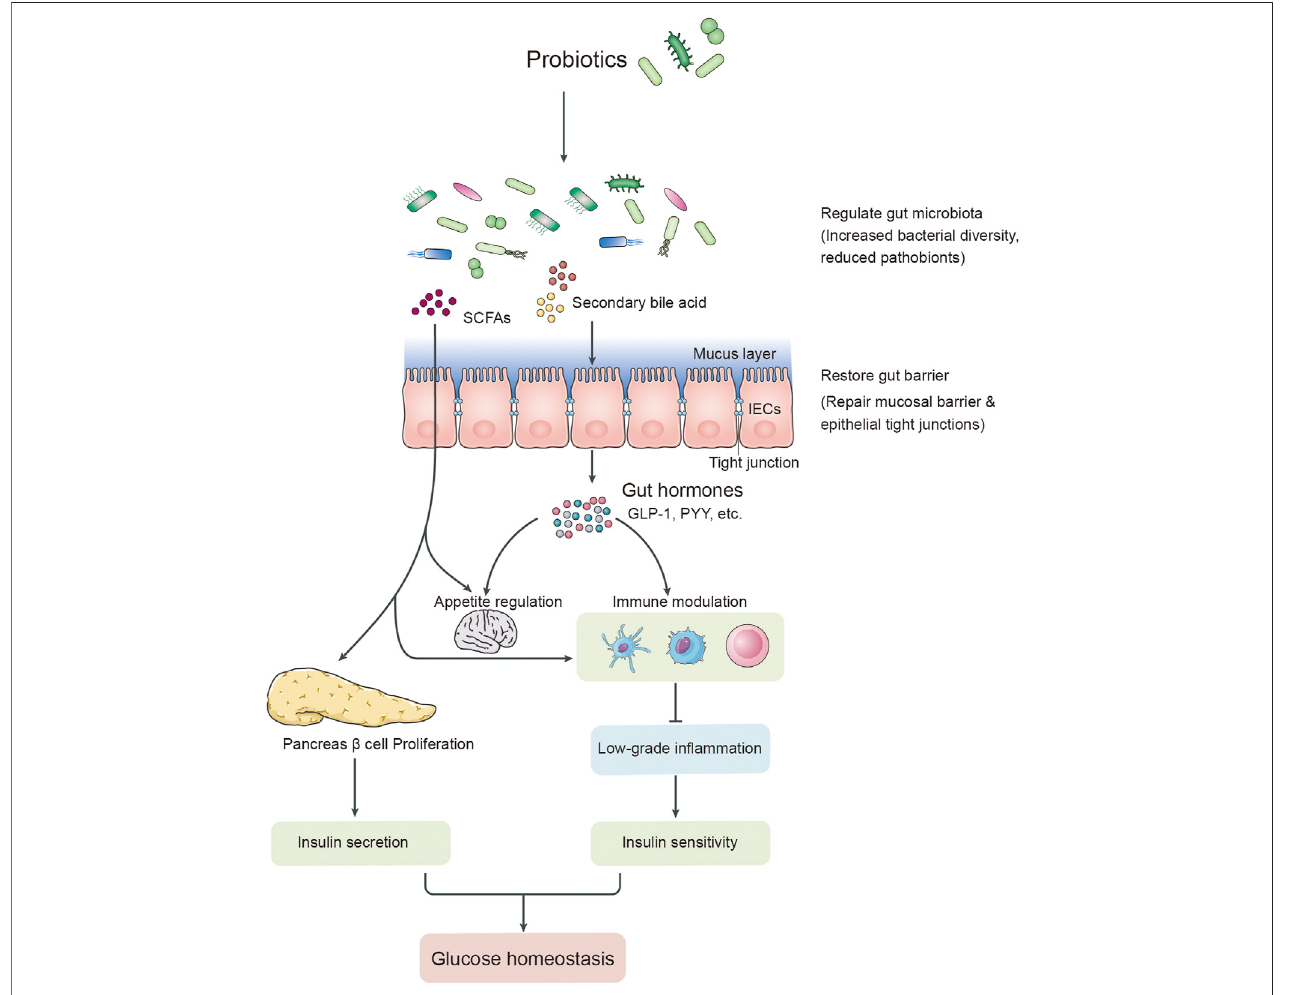
FIGURE 7 | The possible mechanism linking probiotic supplementation and